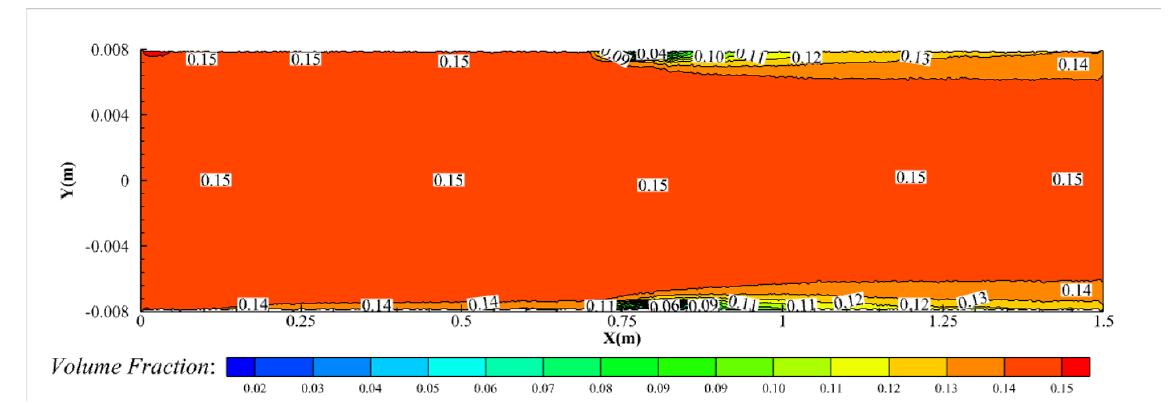
Figure 7. Distribution of IVF, solid velocity, pressure and temperature at different cross-sections with local large heat flux value of 40 kW/m 2 .